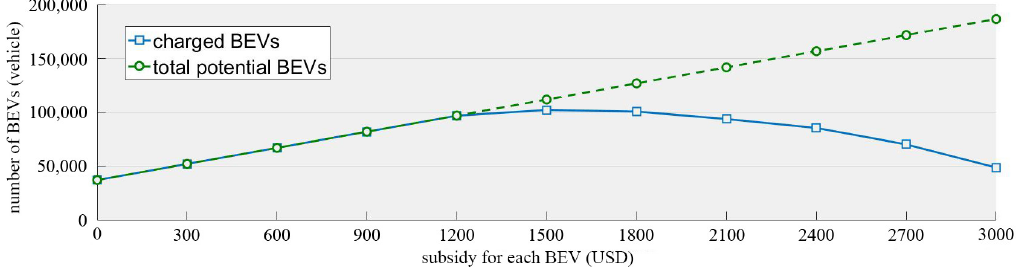
Figure 4. Highway network of Hunan Province.